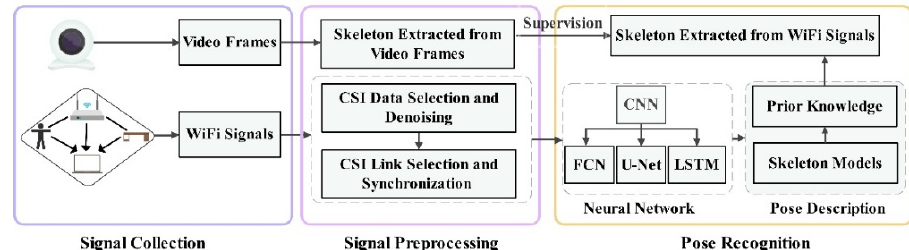
Figure 11. System overview of CSI pose construction.